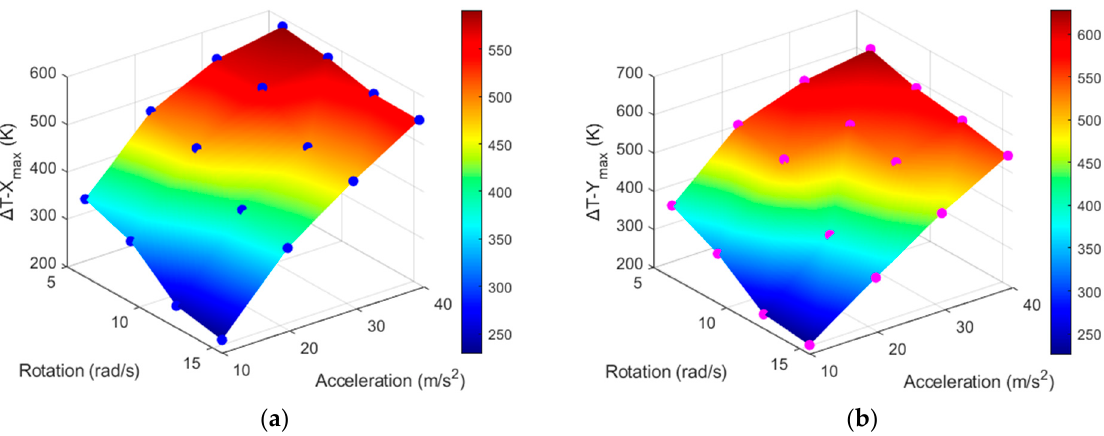
Figure 16. Δ T_X max ( a ) and Δ T_Y max ( b ) produced with the given acceleration and rotation.